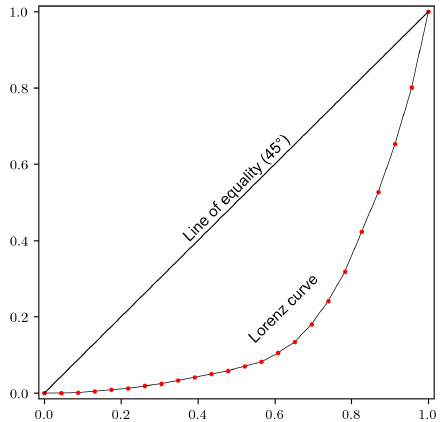
Figure 12. Lorenz curve of the contribution of the individual shifted field, where the x axis denotes the cumulative share of population ordered by contribution from the lowest to the highest, and the y axis denotes the cumulative share of contribution. Table 1. Mean time consumption to generate a realization and an expected realization (with and without using the